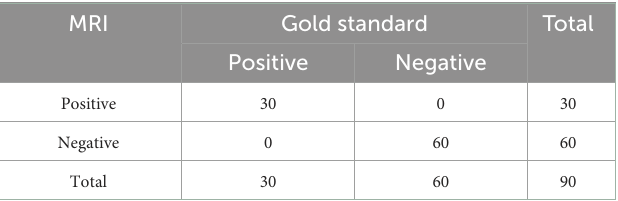
TABLE 3 Positive distribution of MRI and gold standard examination in 90